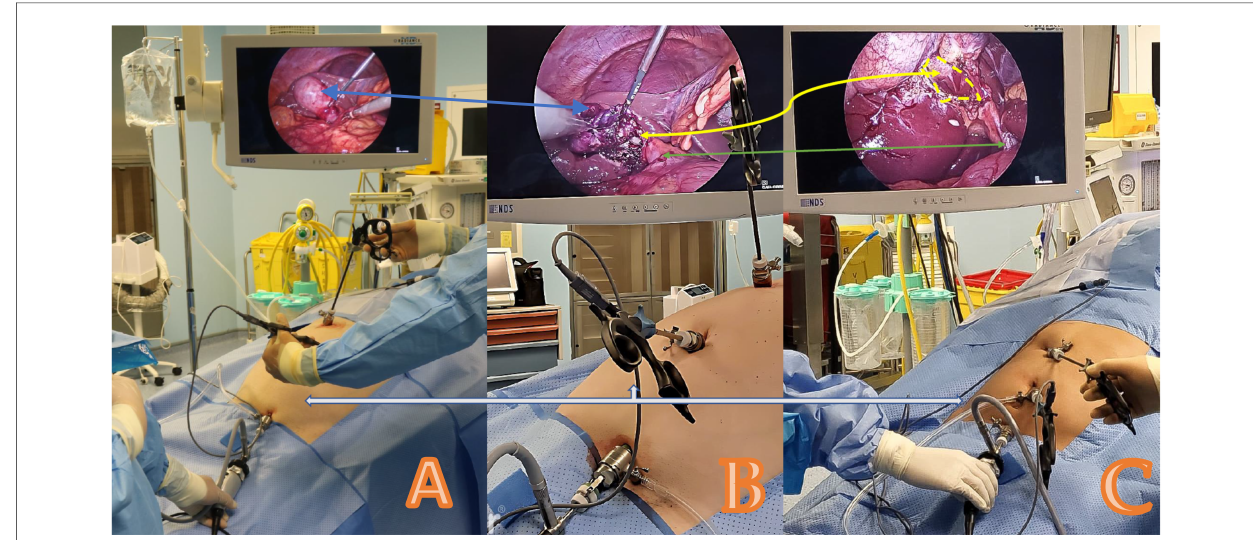
FIGURE 2 Emirate cholecystectomy showing the standard laparoscopic setup and trocar position (karl storz SE & Co. KG, Tuttlingen, Germany). A case of acute cholecystitis is shown in ( A,B ). Blue arrows indicate the hydropic gallbladder ( A ) and the status after bile aspiration ( B ). Another case of typical stone disorder is shown in ( C ). The green arrow points to the common bile ducts. The white arrow represents the 5 mm trocars with the optic in the suprapubic trocar and the intra-umbilical main working trocar; in ( B ), bipolar forceps are used in that trocar to dissect the calot triangles. The yellow arrow indicates the critical view of safety in both cases of acute and chronic cholecystitis performed via the Emirate